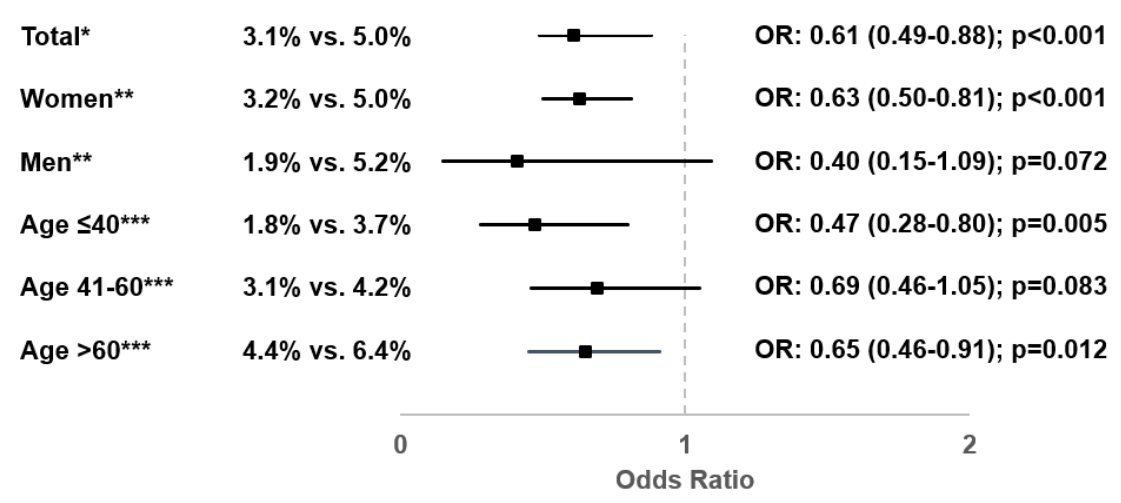
Figure 3. Association between Canephron ® prescription and probability of frequent recurrent UTIs (Canephron ® versus antibiotic). * Multivariable logistic regression adjusted for age, sex, health insurance coverage, practice specialty, and CCI. ** Multivariable logistic regression adjusted for age, health insurance coverage, practice specialty, and CCI. *** Multivariable logistic regression adjusted for sex, health insurance coverage, practice specialty, and CCI.